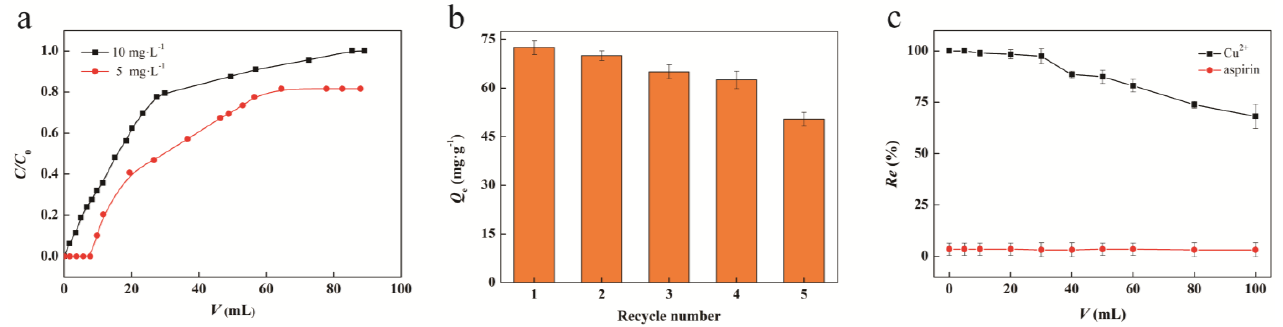
Figure 6. Dynamic adsorption of sandwich membrane: ( a ) Breakthrough curves; ( b ) Recycle num- bers of membrane; ( c ) Dynamic adsorption of sandwich membrane in aspirin − Cu 2+ mixed solution.